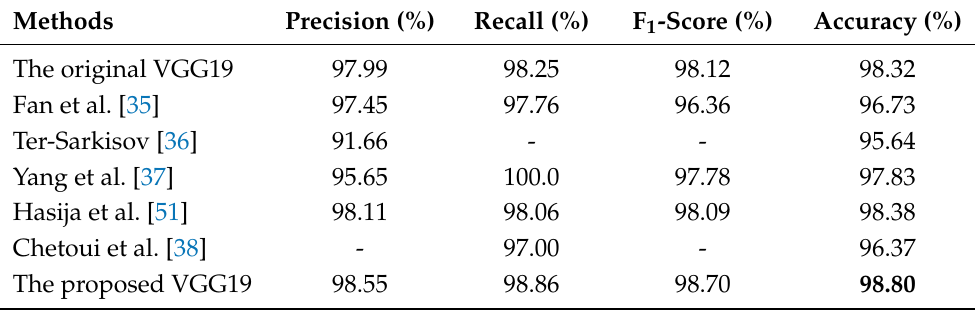
Table 4. Comparison of the proposed and state-of-the-art methods on the COVIDx CT-2A dataset.